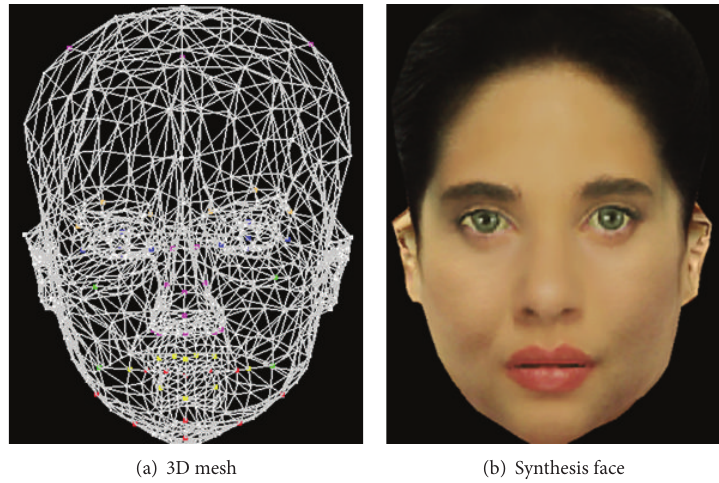
Figure 6: 3D facial expression animation system.